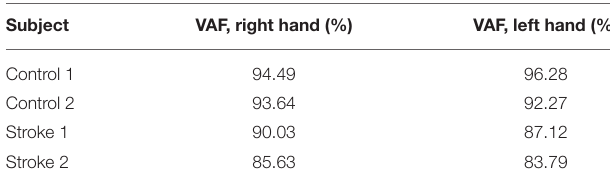
TABLE 2 | The VAF of EEG source localization (inverse model) for each